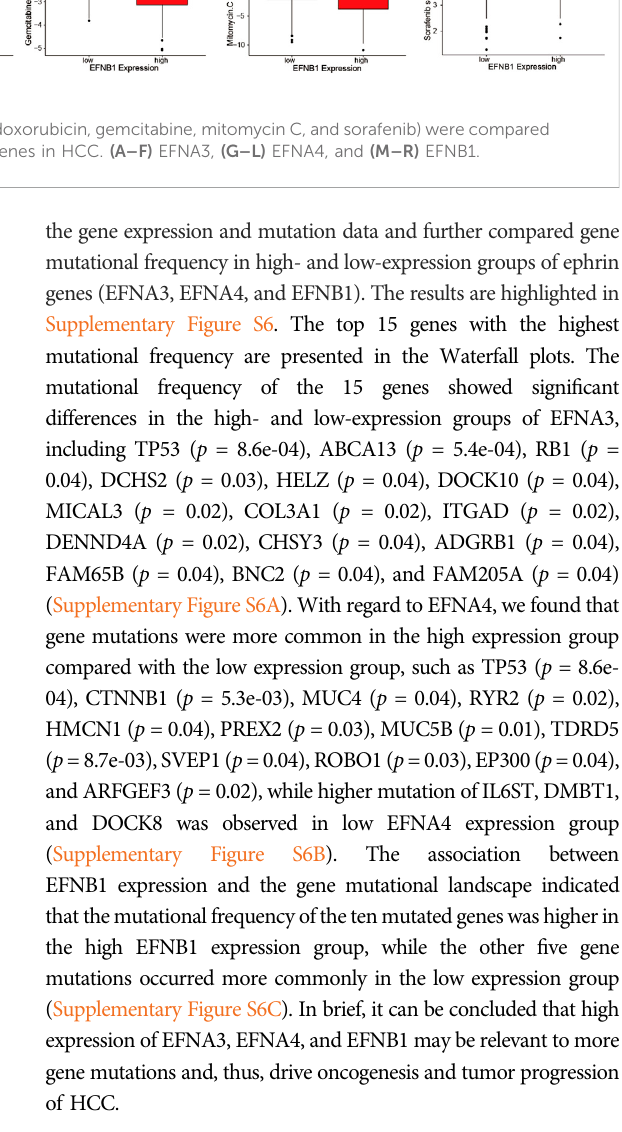
Figure S6B). The association between EFNB1 expression and the gene mutational landscape indicated that themutational frequency ofthetenmutated geneswashigherin the high EFNB1 expression group, while the other fi ve gene mutations occurred more commonly in the low expression group (Supplementary Figure S6C). In brief, it can be concluded that high expression of EFNA3, EFNA4, and EFNB1 may be relevant to more gene mutations and, thus, drive oncogenesis and tumor progression of